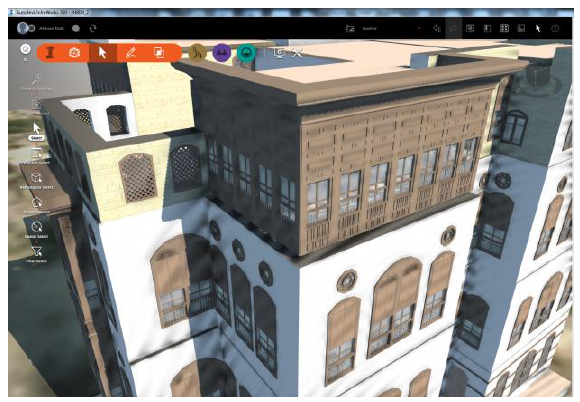
Figure10: the quality of the level of details in Autodesk